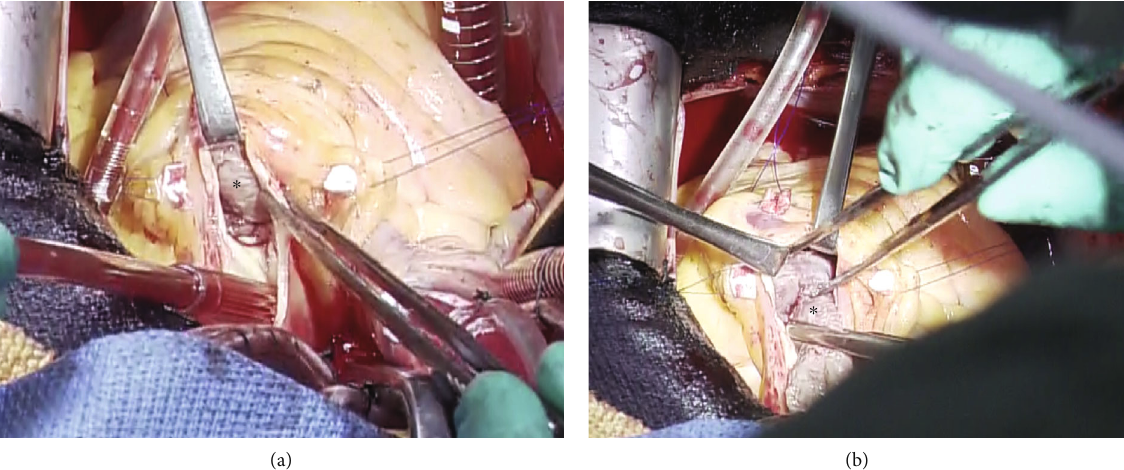
Figure 3: Surgical images via pulmonary artery incision. A large mass (asterisk) in the main pulmonary artery and in the right ventricle via the pulmonary artery incision (a) was removed from the right ventricle